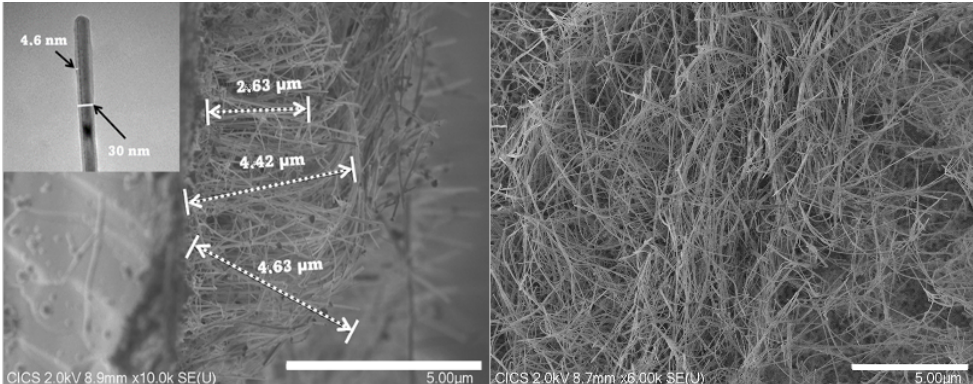
Figure 5. Cross-sectional SEM image of p-type SiO2-SiNWs array. TEM image of SiNW (inset). The insert is a top view